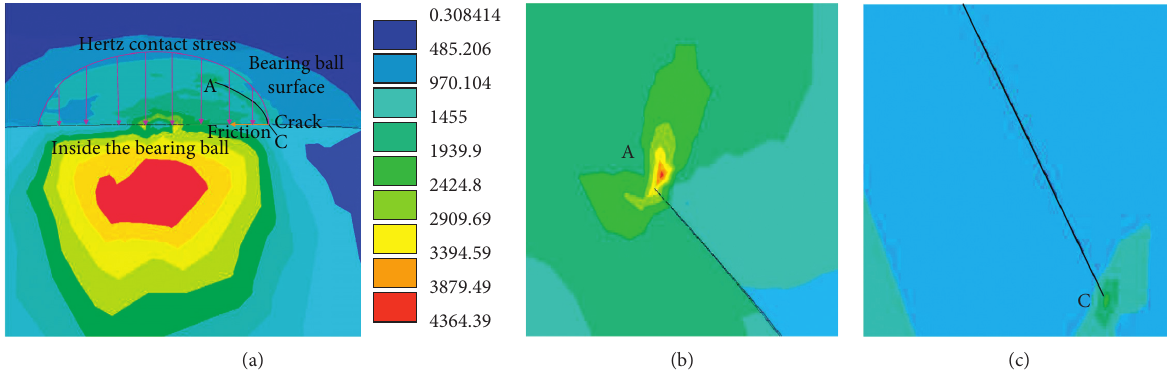
Figure 11: Stress distribution diagram of ceramic ball with crack: (a) the stress contour of the ceramic bearing ball; (b) stress concentration of point A; (c) stress concentration of point C on the front of